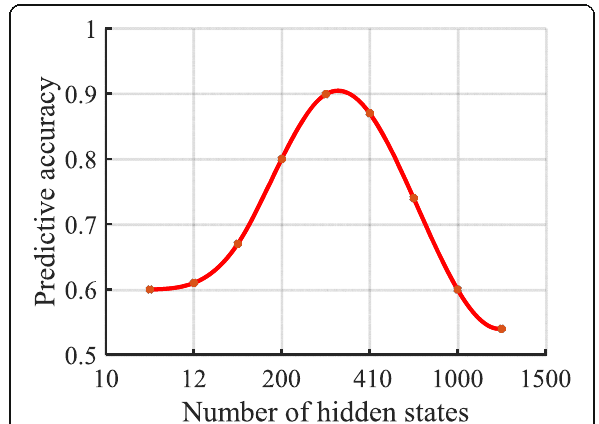
Fig. 9 Influence of the number hidden states on prediction